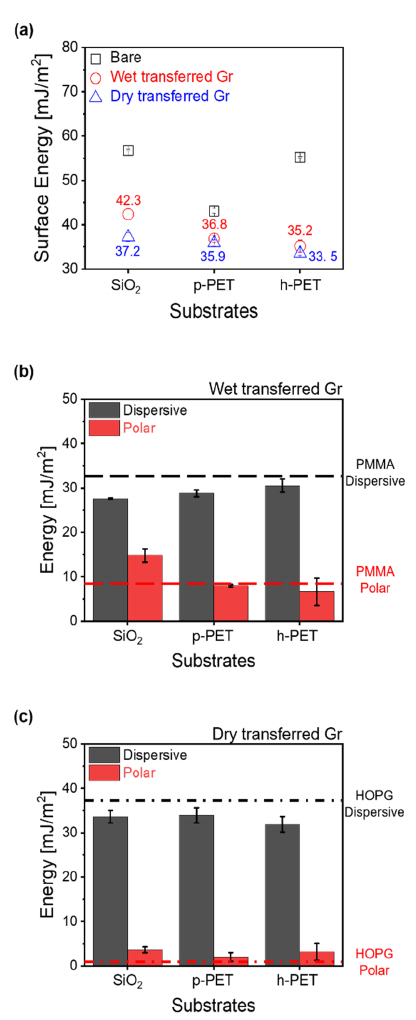
Figure 5. ( a ) Surface energy of bare substrates, and wet- and dry-transferred Gr/substrate. Dispersive and polar energy of ( b ) wet- and ( c ) dry-transferred Gr/substrate. The black and red dotted lines in ( b , c ) represent the dispersive and polar energy of PMMA and HOPG, respectively.